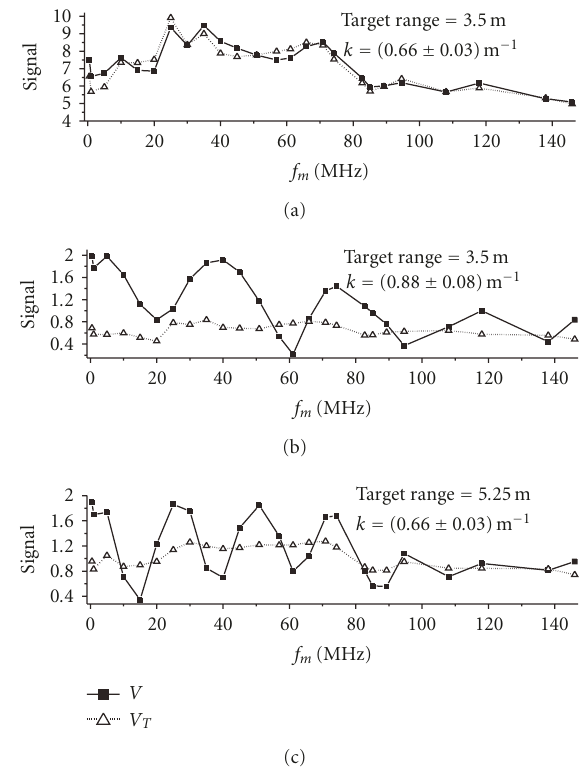
Figure 7: V and V T (a.u.) versus f m for (1) z T = 3 . 5m, k = 0 . 66m − 1 , η = 0 . 08, τ = 2 . 31 (a); (2) z T = 3 . 5m, k = 0 . 88m − 1 , η = 1 . 5, τ = 3 . 08 (b); (3) z T = 5 . 25m, k = 0 . 66m − 1 , η = 0 . 6, τ = 3 . 465